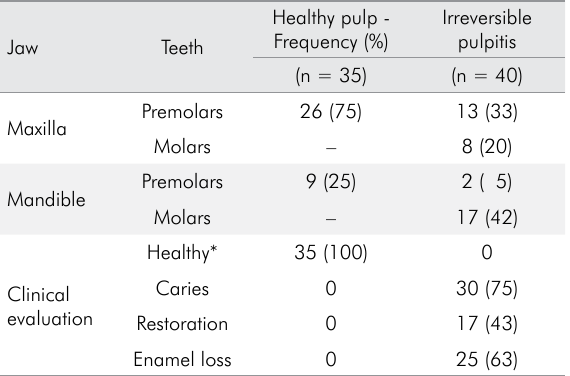
Table 1. Types of teeth and their clinical evaluation (n = 75 teeth).